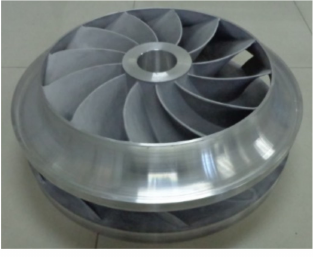
Figure 3. Experimental sample of centrifugal fan.